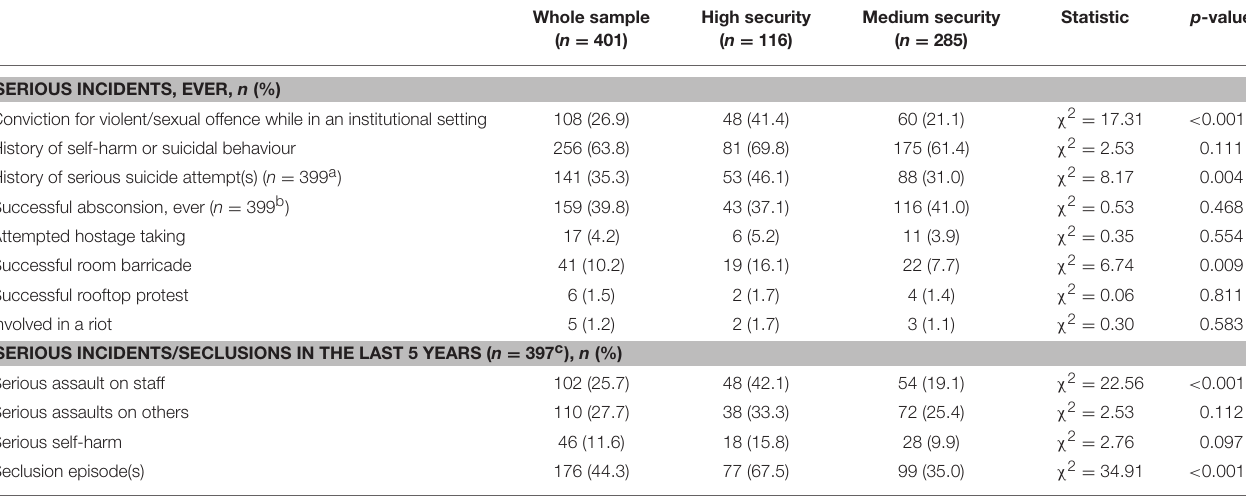
TABLE 5 | Institutional behaviour of long-stay forensic patients.